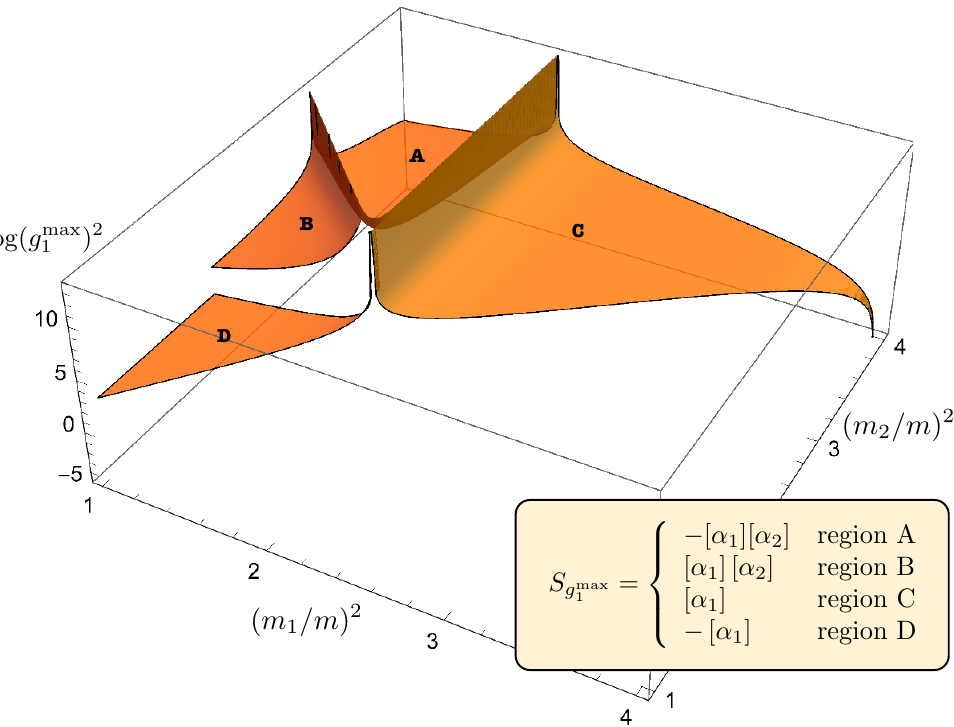
Figure 10 . Maximal coupling g max ( m 1 =m; m 2 =m ) for the spectrum m 1 < m 2 < 2 m and no 1